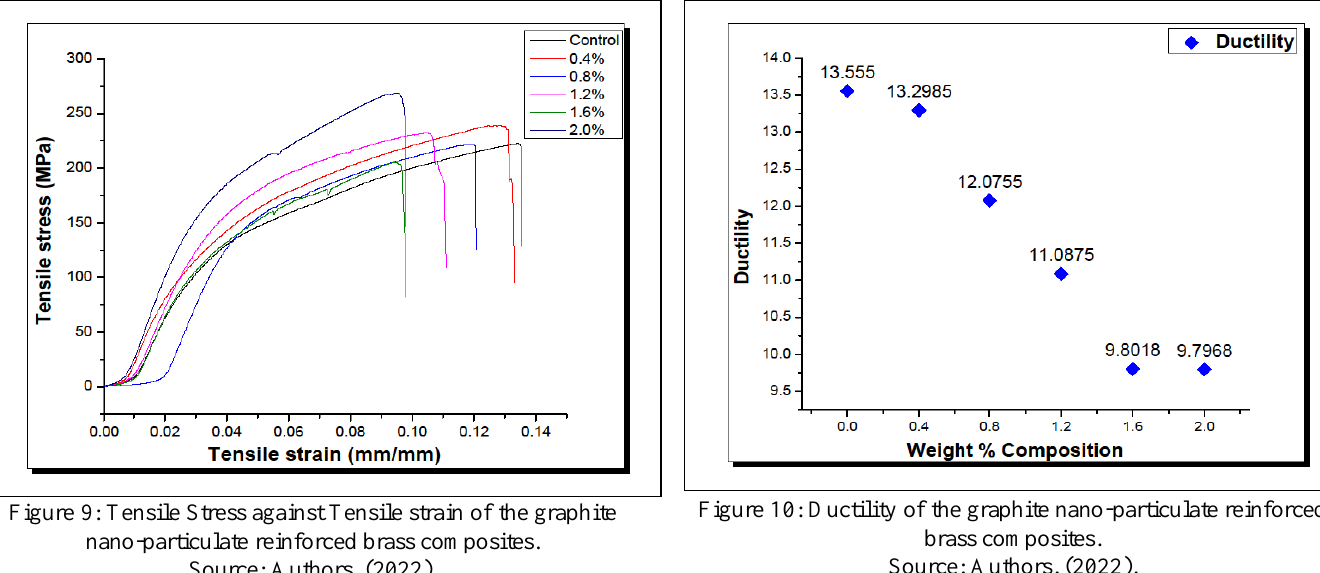
Figure 10: Ductility of the graphite nano-particulate reinforced brass composites. Source: Authors, (2022).